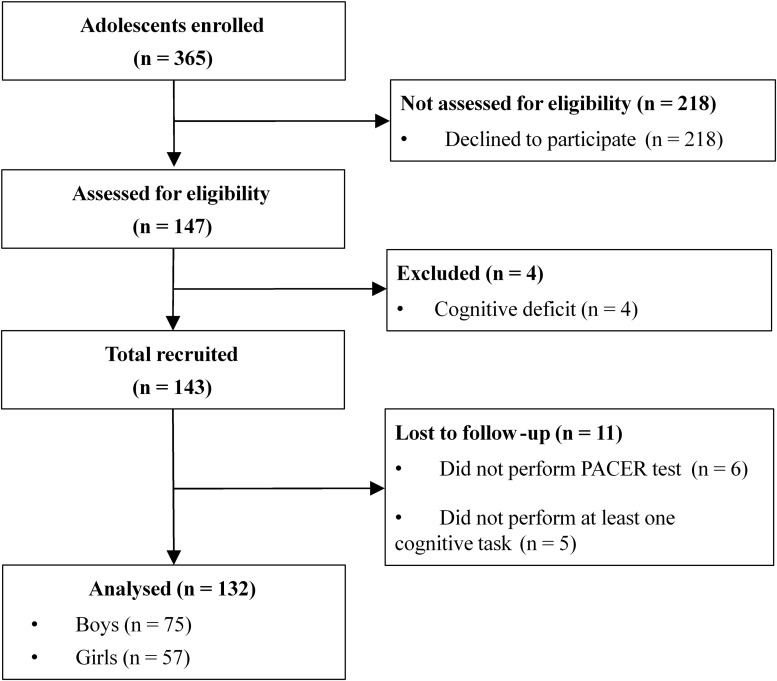
Study flow diagram. PACER, progressive aerobic cardiovascular endurance run test.